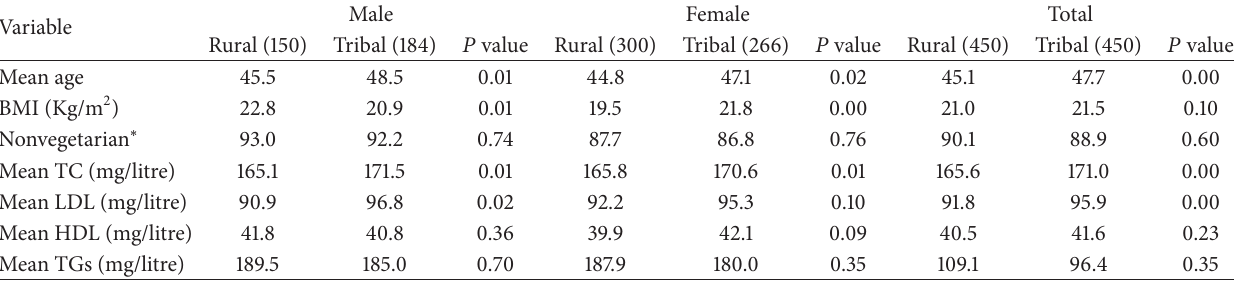
Table 1: Lipid profile for rural and tribal area of a Himalayan state, Himachal Pradesh, India, 2010. Variable